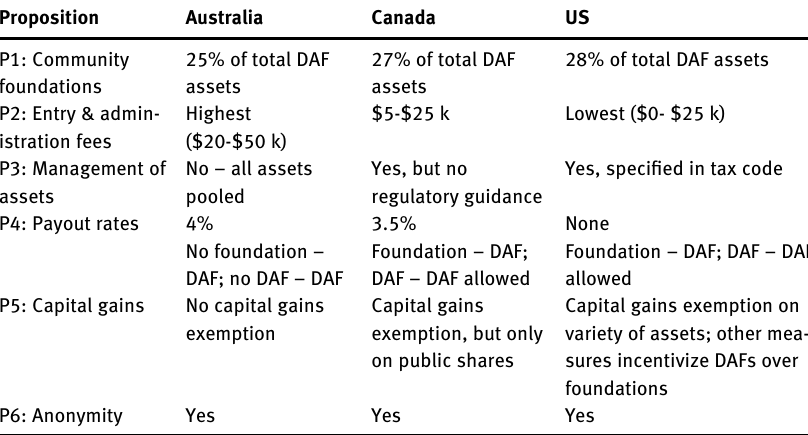
Table  : Comparison of DAF suppliers and regulations.